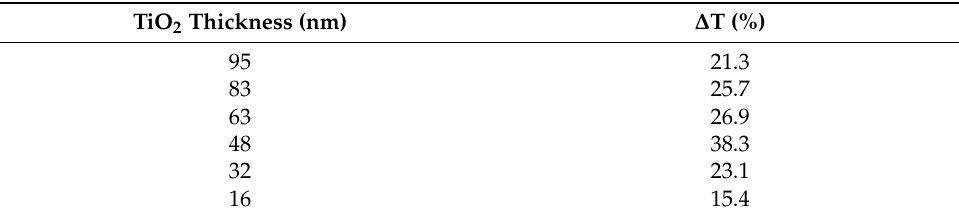
Table 2. Transmittance modulation of EC devices at 550 nm for different TiO 2 thicknesses.